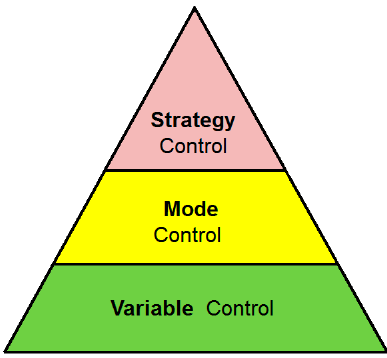
Figure 2. Control pyramid for a solar thermal power plant.